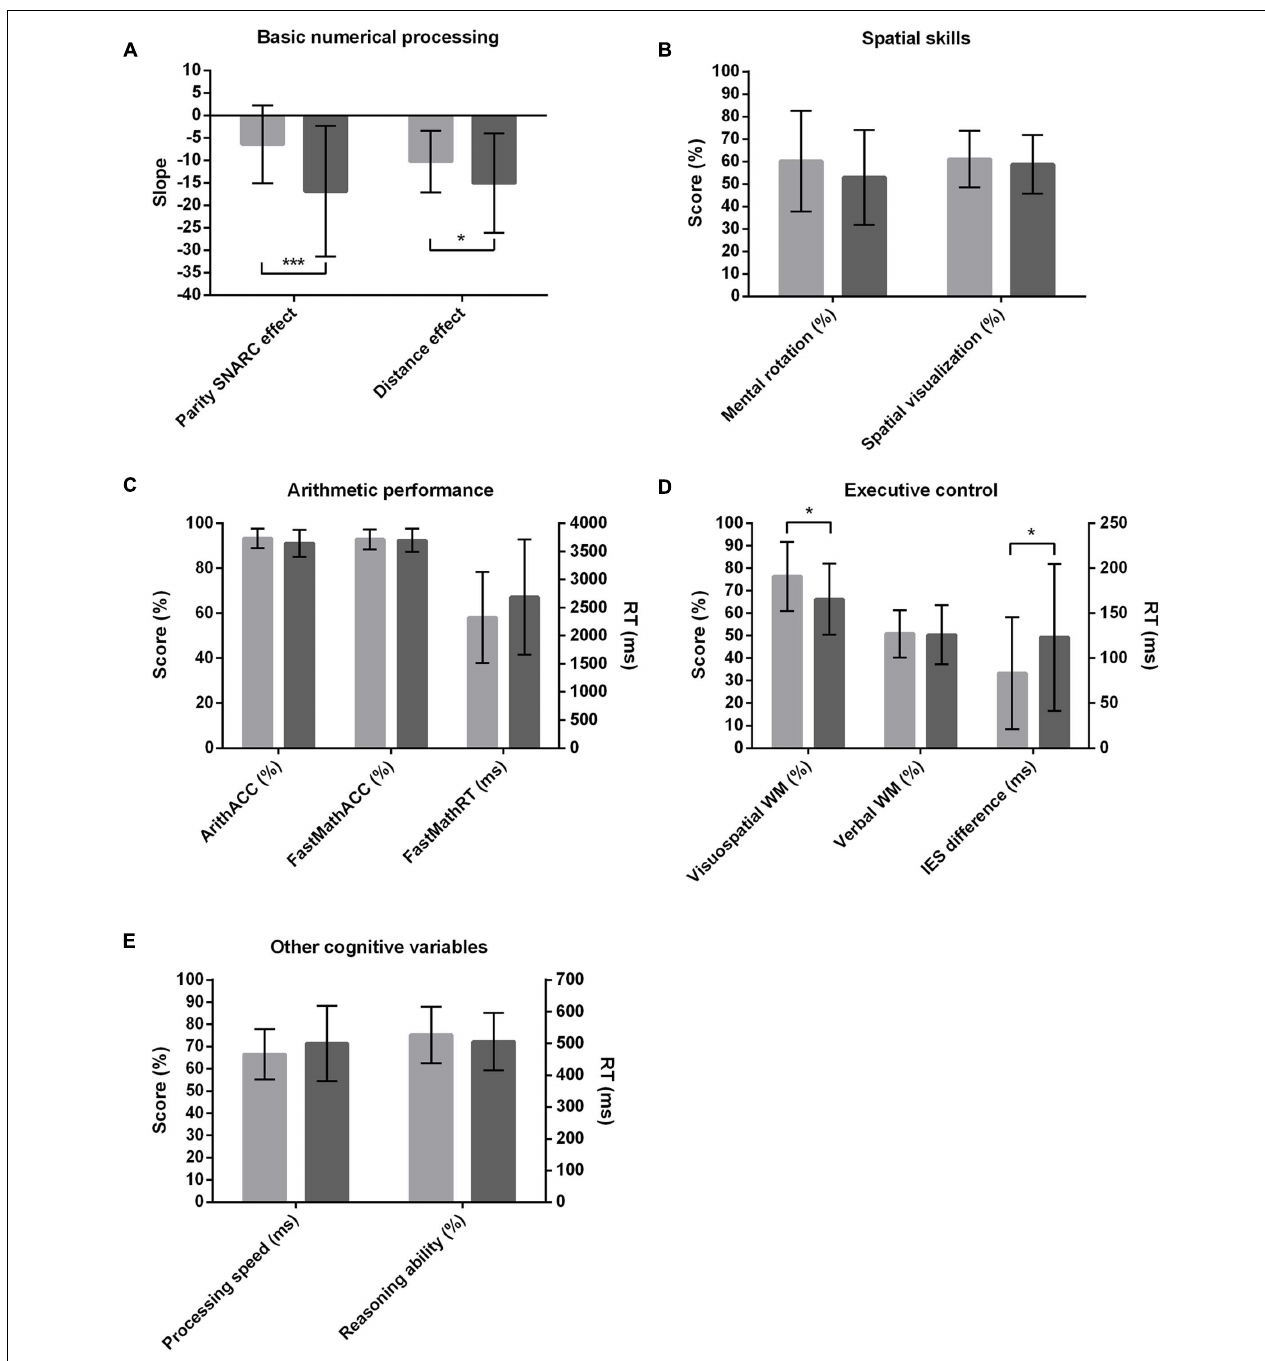
FIGURE 1 | Performances in the low (bright shading) and high (dark shading) math anxiety groups in the tasks probing basic numerical processing (A), spatial skills (B), arithmetic performance (C), executive control (D), and cognitive variables such as processing speed and reasoning ability (E). Score, d (cid:48) and span values are expressed as percentages of maximum values. Error bars represent standard deviations. ∗ p < 0.05; ∗∗∗ p < 0.001.